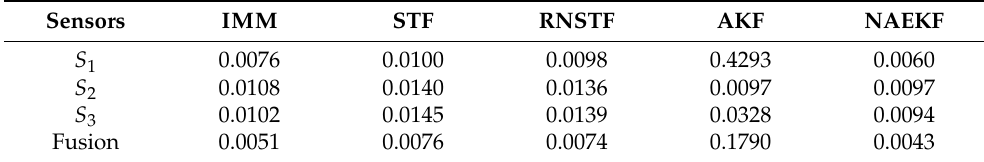
Table 7. Estimation errors of the elevation angle ( ◦ ).